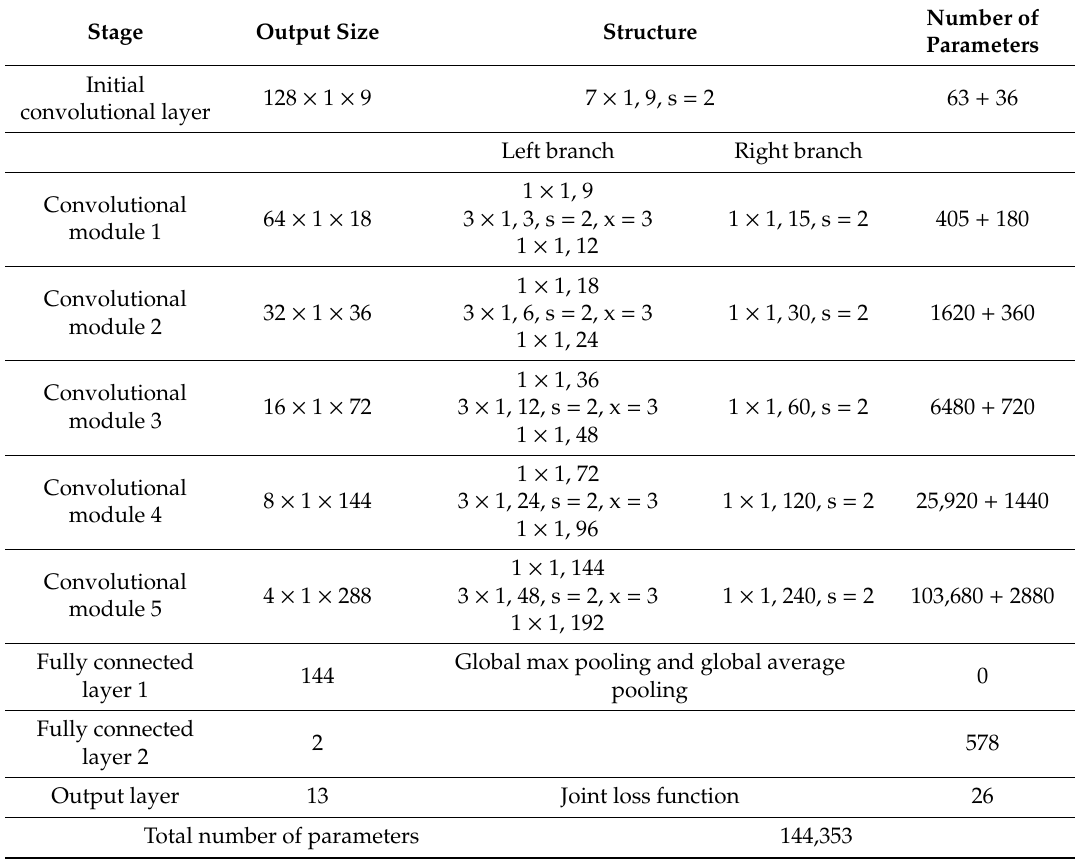
Table 8. Details of structure and parameters of each stage in model